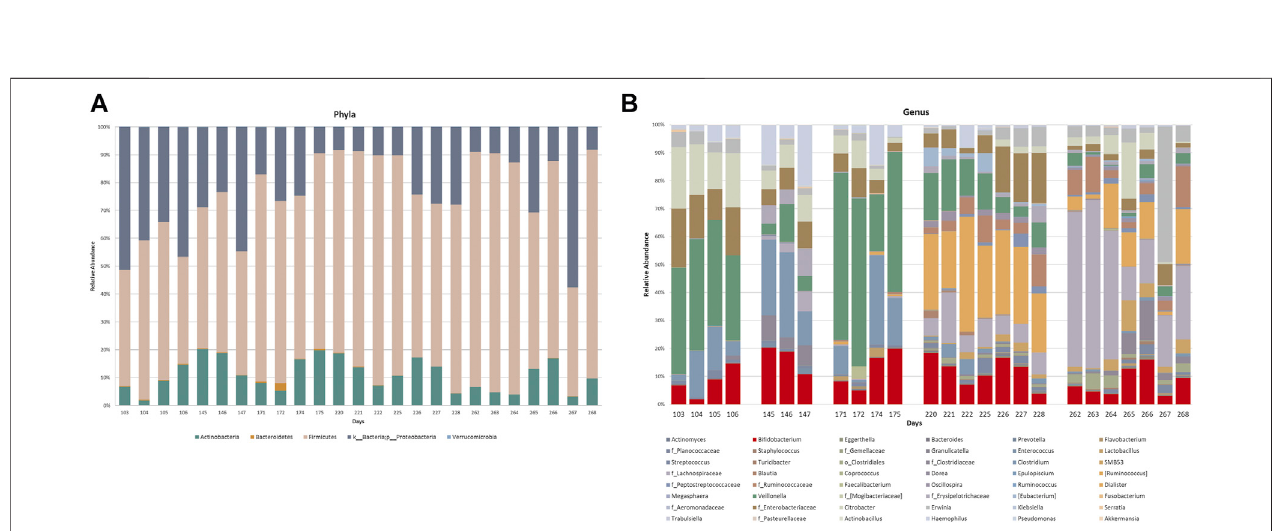
FIGURE6 | Relative abundance of OTUsat phylum (A) and genus (B) levels ofthegut microbiota pro fi ling. Where thegenus level wasnot detectable, order(o_)or family (f_) was reported.